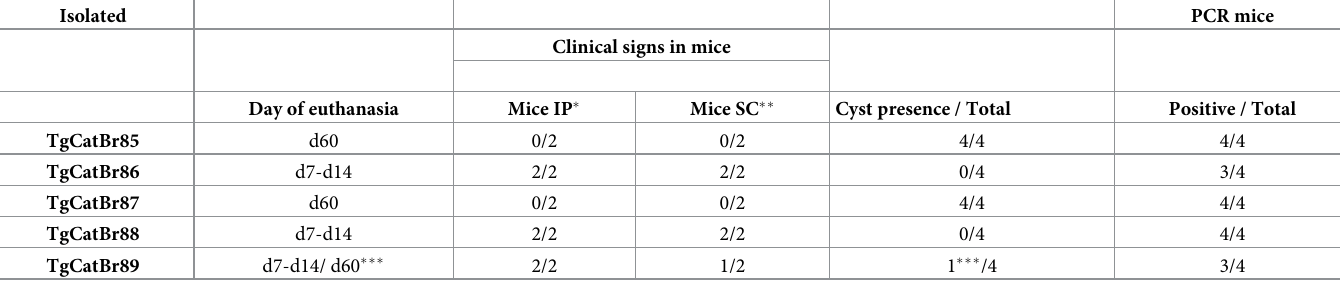
Table 1. Detection of Toxoplasma gondii by PCR in samples from naturally infected cats, associated with the bioassay.